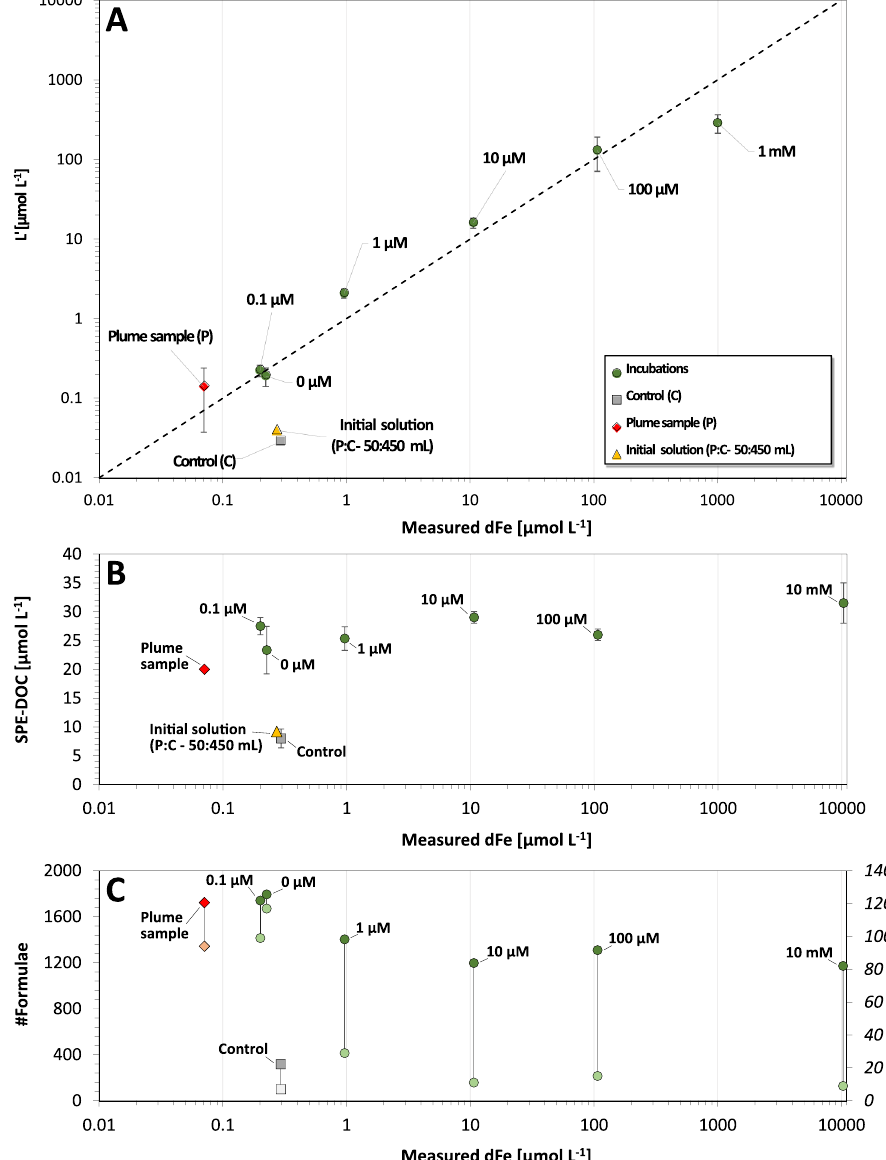
Figure 3. ( A ) Measured dissolved Fe (dFe) versus excess ligand concentrations (L ′ ) in the different incubations including the original plume sample. The initial solution was calculated from values of the original plume and the pure ASW. ( B ) Final average SPE-DOC concentrations in the different incubation sets. ( C ) Total number of different formulae identified in the SPE-DOM isolated from the different samples. The connected second, light colored symbol for each sample refers specifically to the number of Fe-containing